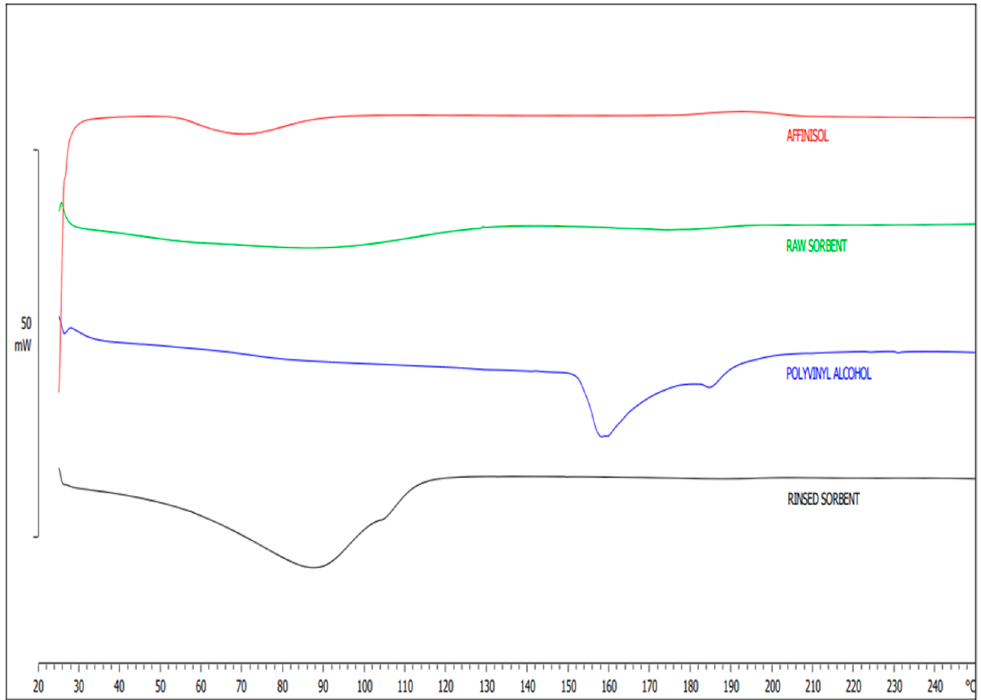
Figure 2. Over laid DSC thermograms of A ffi nisol TM (HPMC HME 15 LV), raw sorbent, polyvinyl alcohol and rinsed sorbent.